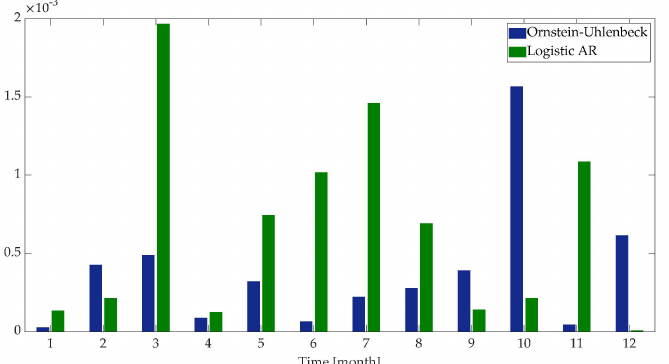
Figure 10. Errors of the mean evaluated with characterization by logistic–AR and Ornstein– Uhlenbeck